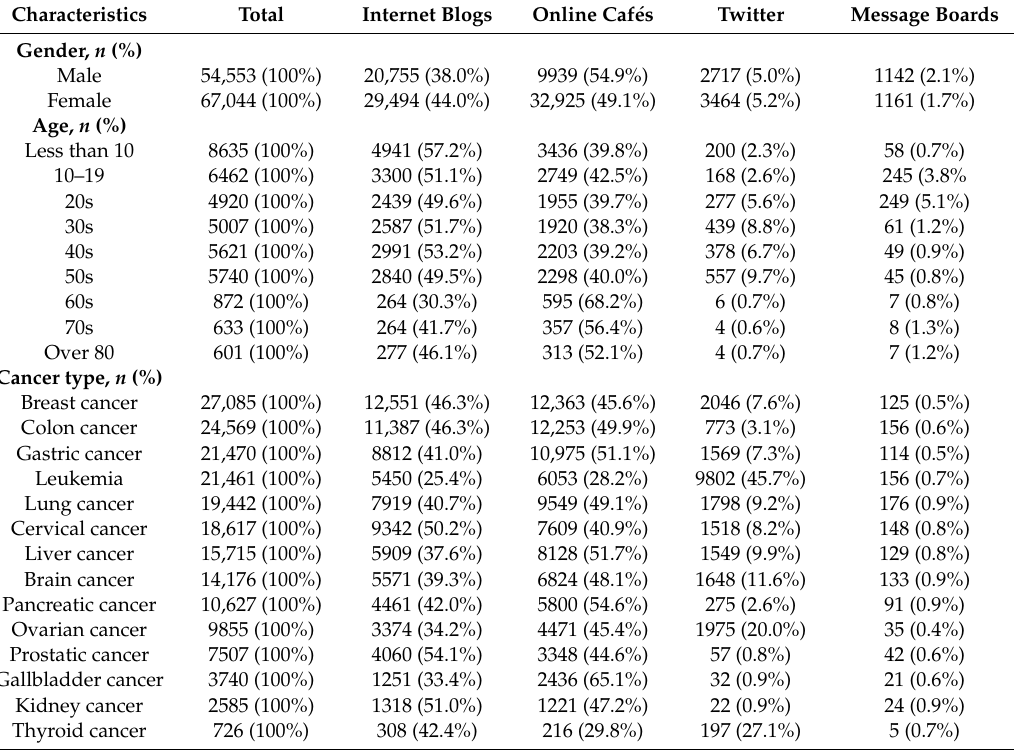
Table 1. Frequency of general characteristics on social media